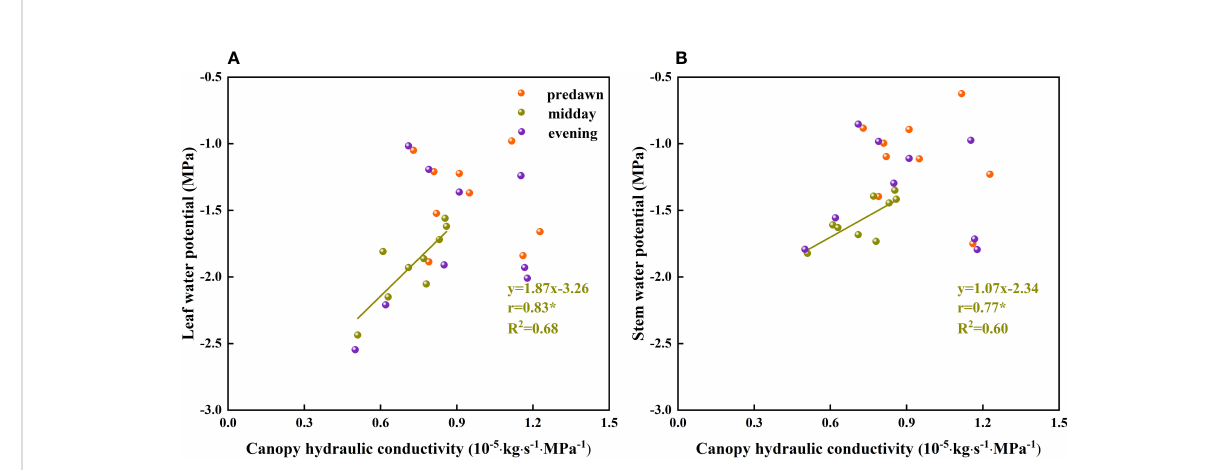
FIGURE 12 The relationship between the plant water potential and canopy hydraulic conductivity of Ferula bungeana . (A, B) present data for the relationships between leaf and stem water potentials and canopy hydraulic conductivity,